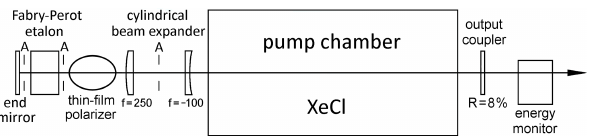
Figure 4. Top view of the modified Lambda SX laser system; 36mm × 36mm square apertures (A) are used for protecting op- tical components from potential powerful reflections from acciden- tally rotated components. The polarizer is oriented out of plane at Brewster’s